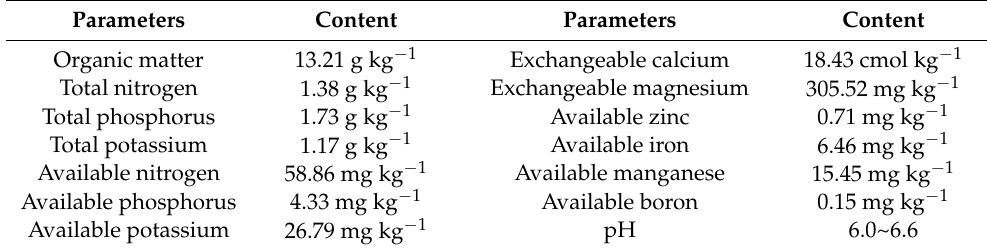
Table 1. The fertility of planting soils of R. roxburghii